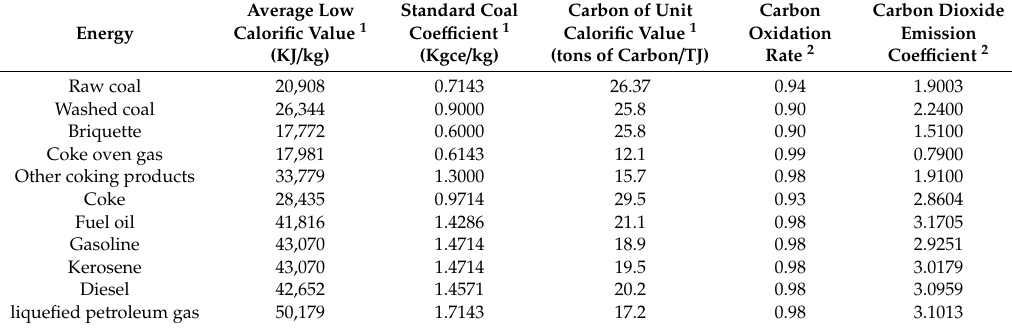
Table 2. Energy calculation coe ffi